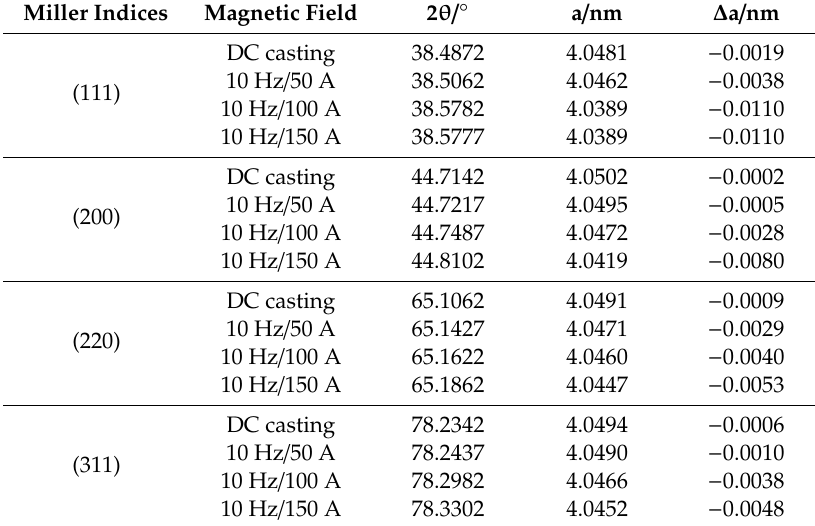
Table3. Latticeparametersof α (Al)of2A97alloyDCcastingatdi ff erentelectromagneticfieldconditions. Miller Indices